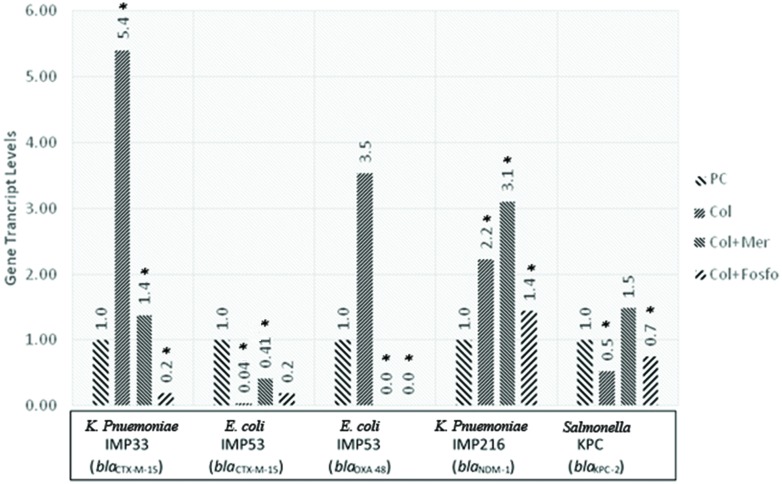
Gene transcript levels in vivo for the genes blaCTX-M-15, blaCTX-M-15 and blaOXA-48, blaNDM-1, blaKPC-2 in their respective isolates IMP33, IMP53, IMP216, and KPC treated with Colistin, Colistin+Meropenem, or Colistin+Fosfomycin at the MIC levels. IMP33: colistin: 5.40 (p = 0.053), colistin and meropenem: 1.38 (p = 0.038), colistin and fosfomycin: 0.19 (p = 0.024). IMP53 (CTX-M-15): colistin: 0.04 (p = 0.038), colistin and meropenem: 0.41 (p = 0.029), colistin and fosfomycin: 0.19 (p = 0.096). IMP53 (OXA-48): colistin: 3.53 (p = 0.221), colistin and meropenem: 0 (p = 0.041), colistin and fosfomycin: 0 (p = 0.049). IMP216: colistin: 2.22 (p = 0.043), colistin and meropenem: 3.10 (p = 0.021), colistin and fosfomycin: 1.44 (p = 0.052). KPC: colistin: 0.53 (p = 0.026), colistin and meropenem: 1.49 (p = 0.980), colistin and fosfomycin: 0.75 (p = 0.042). PC, positive control; Col, colistin; Mer, meropenem; Fos, fosfomycin.